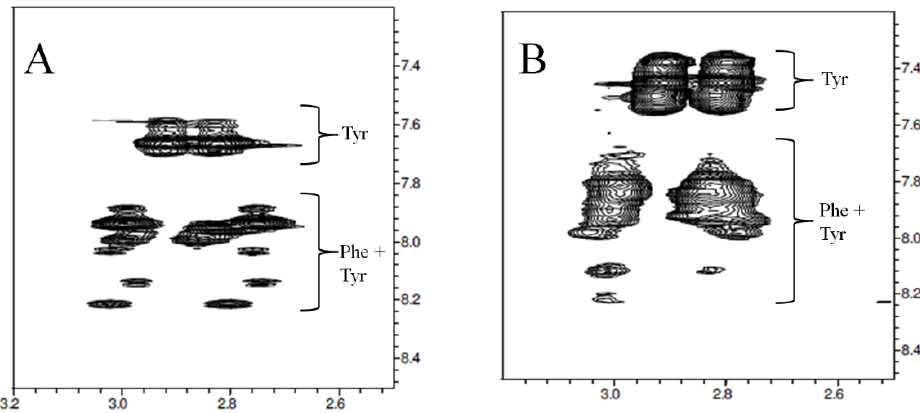
Figure 2. ( A ) Expansion of the Tocsy map of P31–43 in water showing the NH-ββ’CH2 scalar correlation peaks of Phe36 and Tyr43 residues. ( B ) Same map expansion of the Tocsy experiment performed for P31–43 in SDS 150 mM.